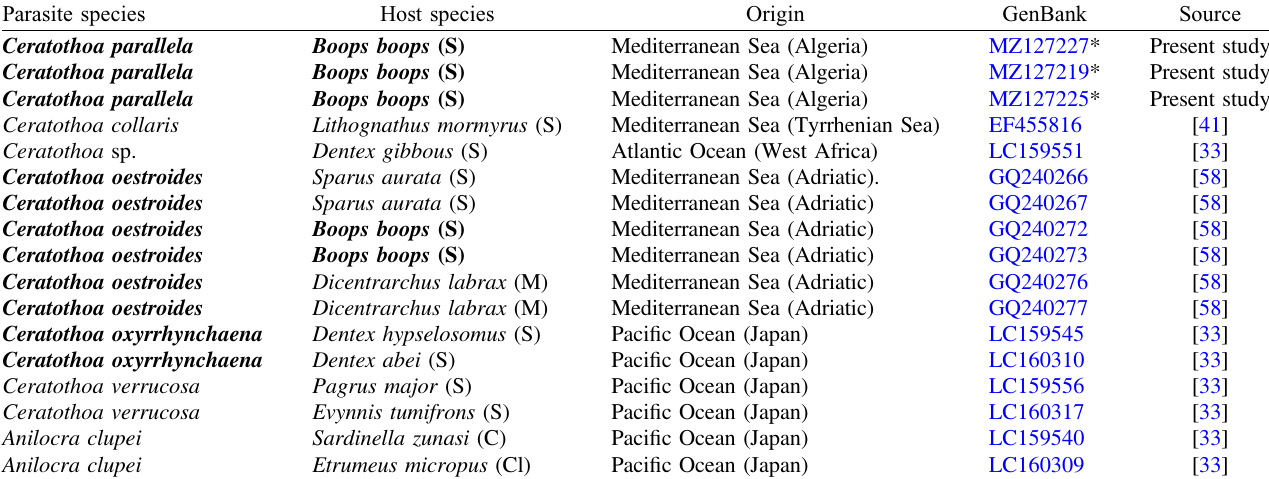
Table 4. Accession numbers of COI sequences used in the molecular analysis of cymothoids. All Ceratothoa species infect the buccal cavity of their fi sh host, whereas individuals of Anilocra clupei infect the body surface of the fi sh. Species previously reported as hosts of Cyclocotyla bellones or as hosts for crustaceans bearing the latter are in bold. S, Sparidae. M, Moronidae. C, Carangidae. Cl, Clupeidae. *, new